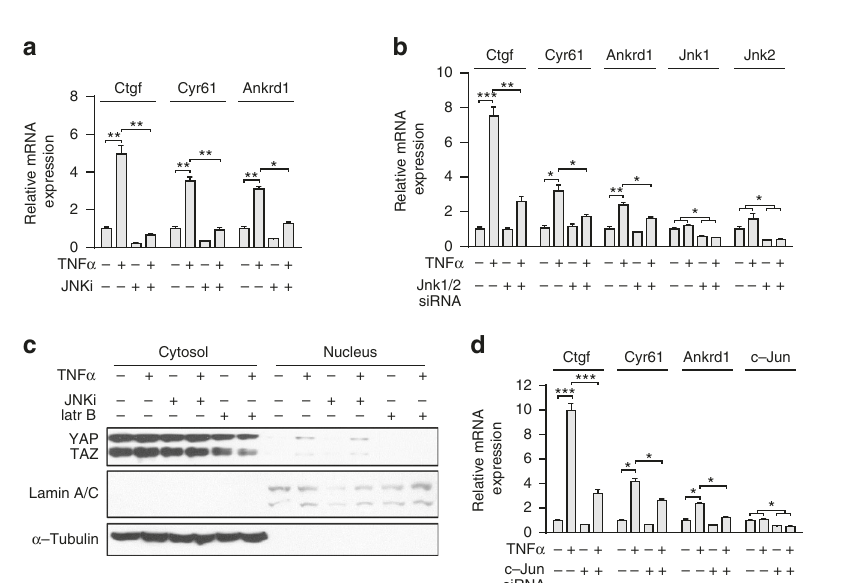
Fig. 6 JNK and c-JUN mediate TNF α -induced YAP/TAZ transcriptional activity. a – d Differentiated 3T3-L1 adipocytes were incubated in the absence or presence of the JNK inhibitor SP600125 (JNKi, 5 µ M) ( a , c ), latrunculin B) (latr B, 2.5 µ M) ( c ), or were treated with control siRNA or siRNA directed against Jnk1 and 2 ( b ) or c-Jun ( d ). Thereafter, cells were incubated in the absence or presence of TNF α (1.1 nM), and expression of YAP/TAZ target genes was determined ( n = 3) ( a , b , d ) or cytosolic and nuclear fractions were analyzed by immunoblotting using antibodies against YAP and TAZ, Lamin A/C or α - Tubulin ( c ). Shown are mean values mean ± SEM; * p ≤ 0.05, ** p ≤ 0.01, and *** p ≤ 0.001 (one-way ANOVA). Source data are provided as a Source Data fi